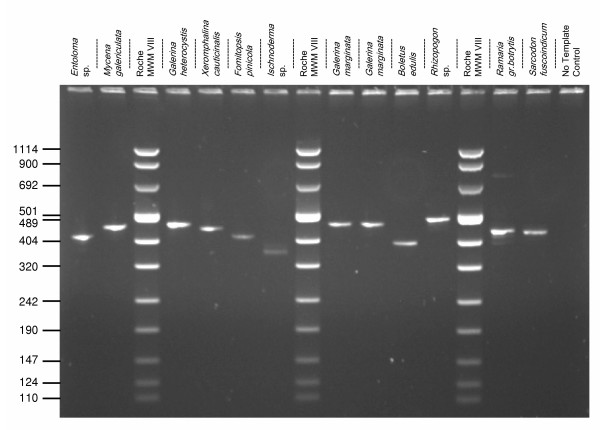
Example of the nested NSI1/NLB4 PCR reaction applied to single-species fungal DNA extracts. Ethidium Bromide fluorescence image showing electrophoresis of nested NSI1/NLB4 PCR product for a group of sporocarp extracts. Gel was run with 0.7% high melting point agarose plus 2% Synergel additive (Diversified Biotech, Boston, MA, cat. no. SYN-100). Roche DNA molecular weight marker VIII (cat. no. 1336045) was loaded at 100 ng in lanes 3, 8 and 13 (sizes for fragments to the left of the figure). Ten μL of PCR reaction was loaded in each well for each of the templates listed at the top of the gel as well as the no-template control in the last well.